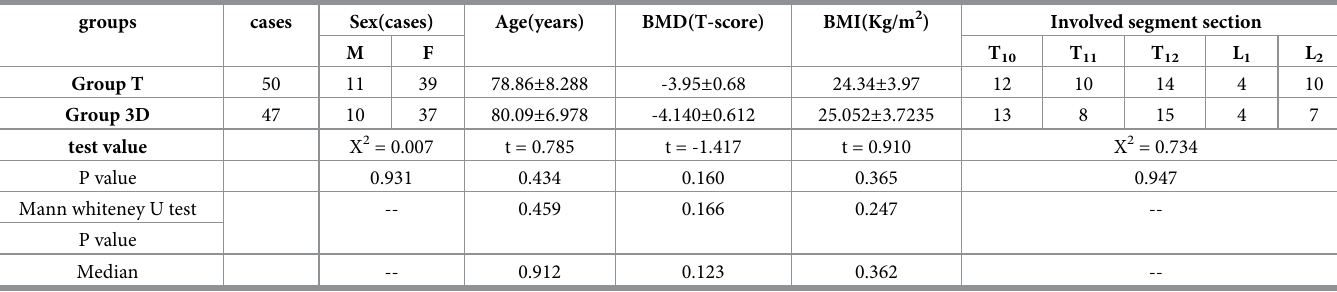
Table 1. Patient characteristics.